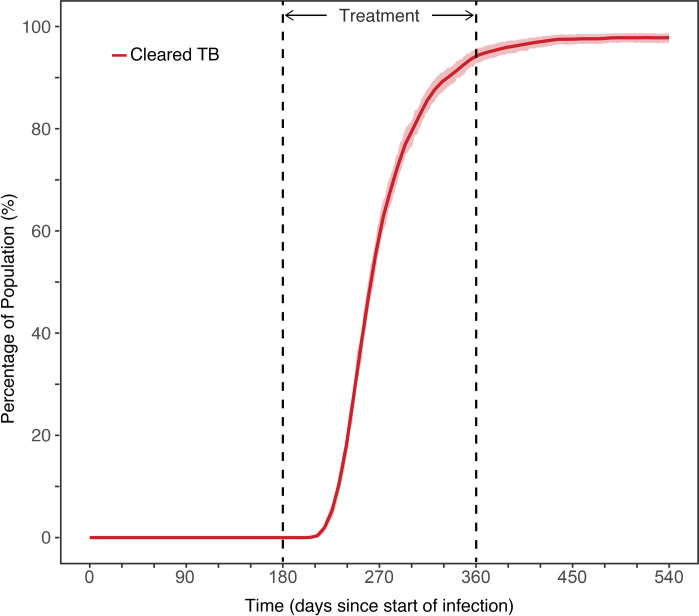
Population TB treatment outcome with standard drug therapy.Summary of outcome of median standard drug treatment of TB infection, based on simulation of 5000 patients, with standard drug therapy (2HREZ/4HR). The TB infection occurs on day 0, and drug therapy is started on day 180.